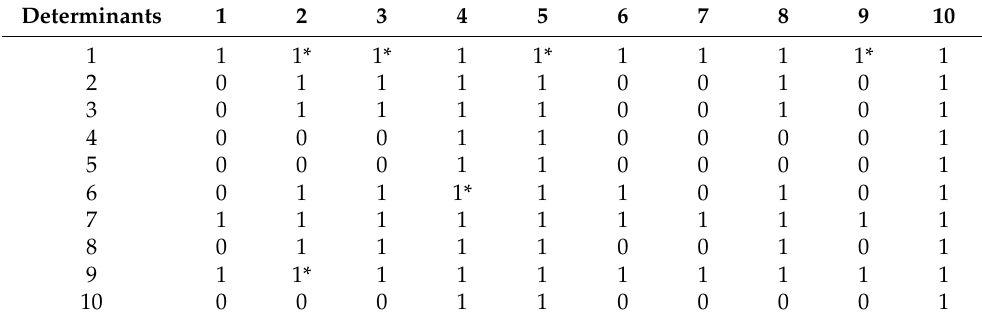
Table 3. Final reachability